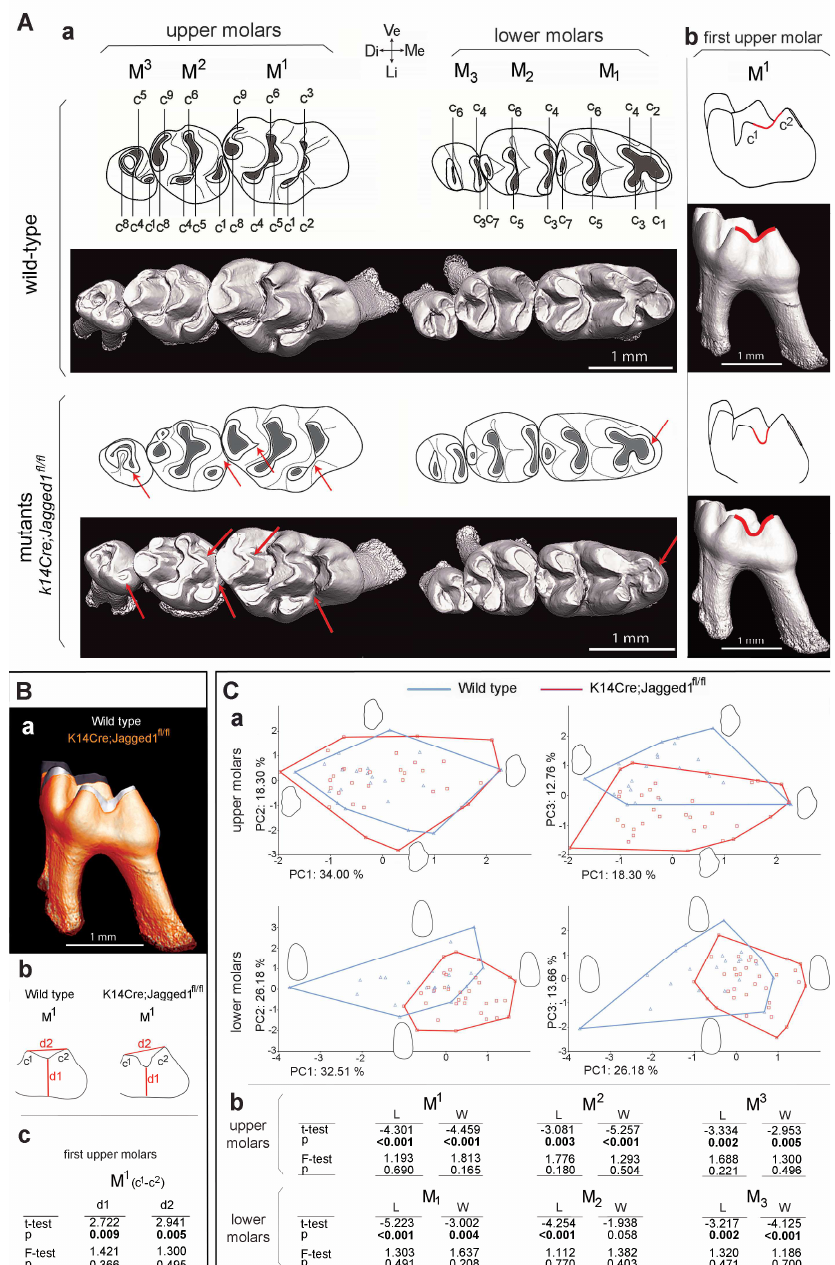
Figure 1. Epithelial loss of Jagged1 affects the molar dental morphology. ( A ) MicroCT analysis showing the morphology of upper and lower molars of wild-type (WT) and K14Cre;Jagged1fl/fl mutant mice (both occlusal and side views). ( Aa ) Morphological variations in location, size and connection of the cusps in molars of the K14Cre;Jagged1fl/fl mice are indicated by red arrows. ( Ab ) WT first upper molar (M 1 ) showing a V-shape c 1 -c 2 connection profile, and mutant M 1 showing a U-shape profile (red lines). In mutant mice, the lower first molars (M 1 ) show in the mesial part mild fusion between the c 1 and c 2 cusps. ( B ) Comparison of the M 1 crowns in WT and Jagged2 mutants. ( Ba ) MicroCT analysis showing smaller crowns in mutant M 1 (orange pseudo color) when compared to the crowns of WT M 1 (grey color). ( Bb , c ) Comparison of the distance between the inter-cusp groove and the basis of the crown (d1) and the distance between c 1 and c 2 (d2) in M 1 of WT and mutants. ( C ) Principal component analyses comparing the variation of dental outline of M 1 and M 1 between WT (blue color) and K14Cre;Jagged1fl/fl (red color) mice. Abbreviations: M, mesial part; D, distal part; V, vestibular part; L, lingual